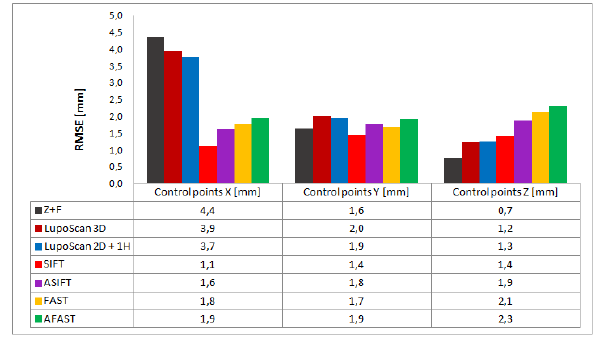
Figure 4. The quality assessment of relative orientation – RSME on marked control points